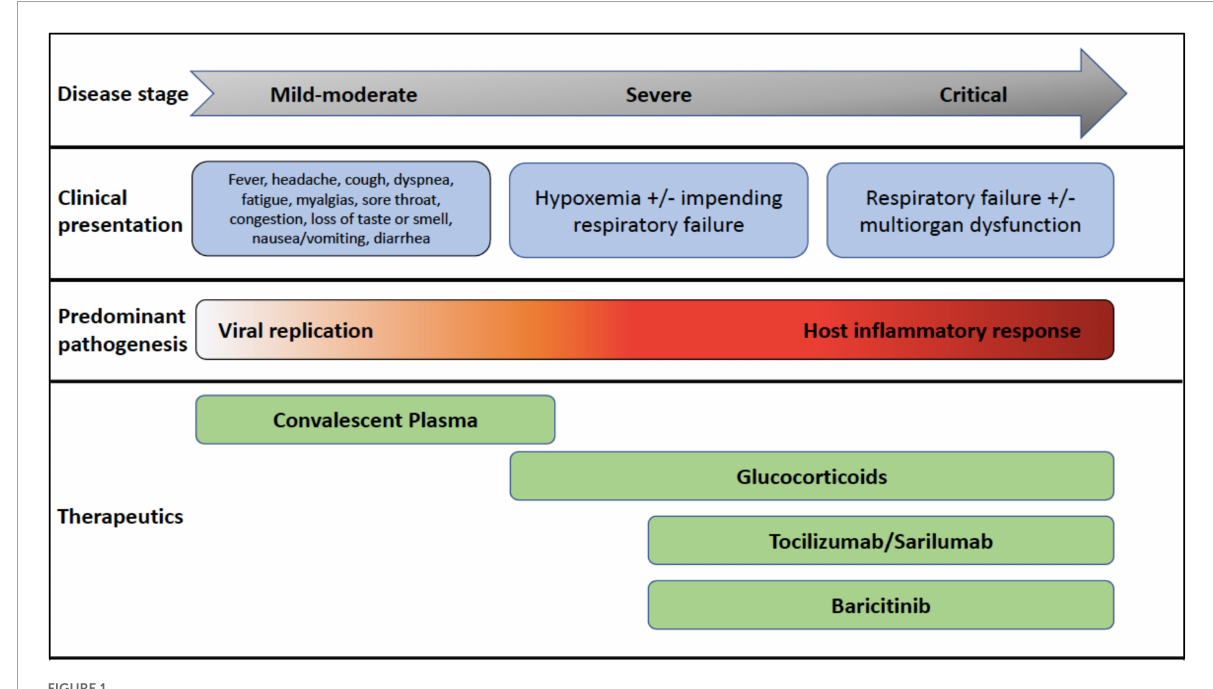
FIGURE1 COVID-19 disease stages, clinical presentations, pathogenesis, and recommended therapeutics most beneficial at each disease